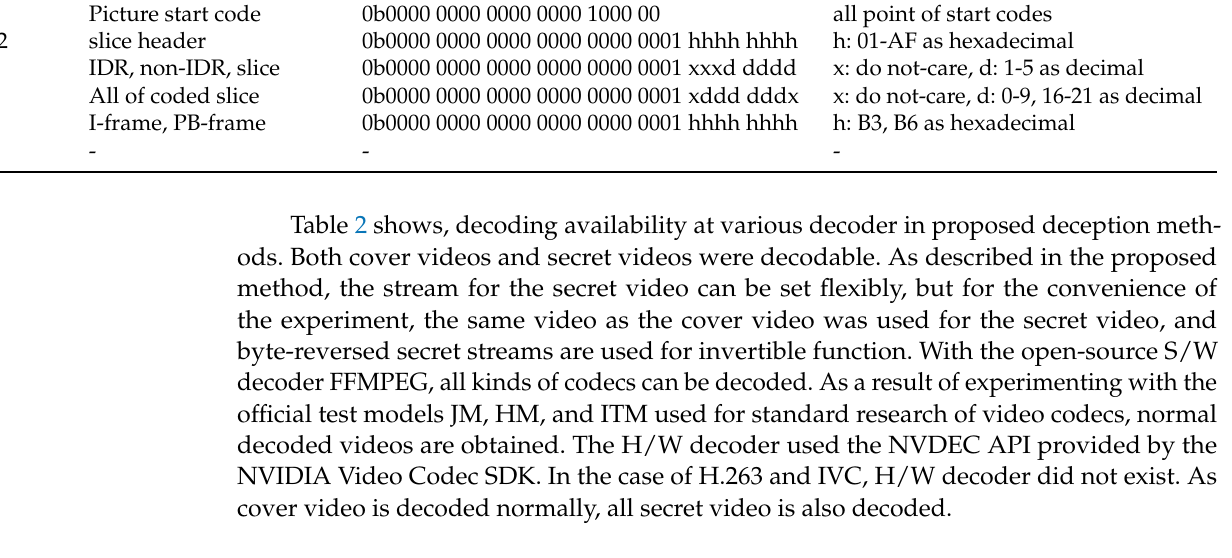
Table 2. Decoding possibility according to codec